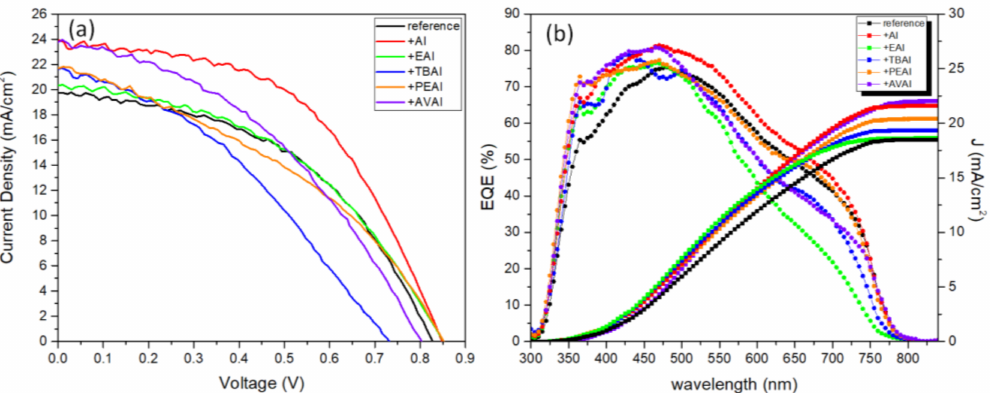
Figure 4. ( a ) Current density–voltage curves of carbon based solar cells, incorporating the 6 perovskites under study, under illumination of 100 mW cm − 2 simulated sun irradiation (1.5 AM) and ( b ) EQE of the corresponding solar